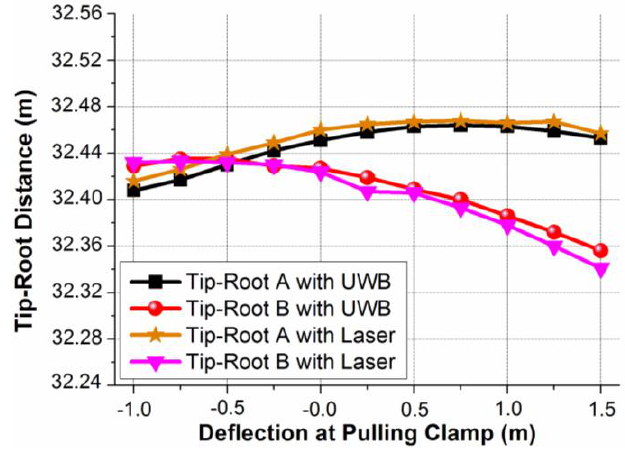
Figure 8. Comparison of the UWB and laser distance